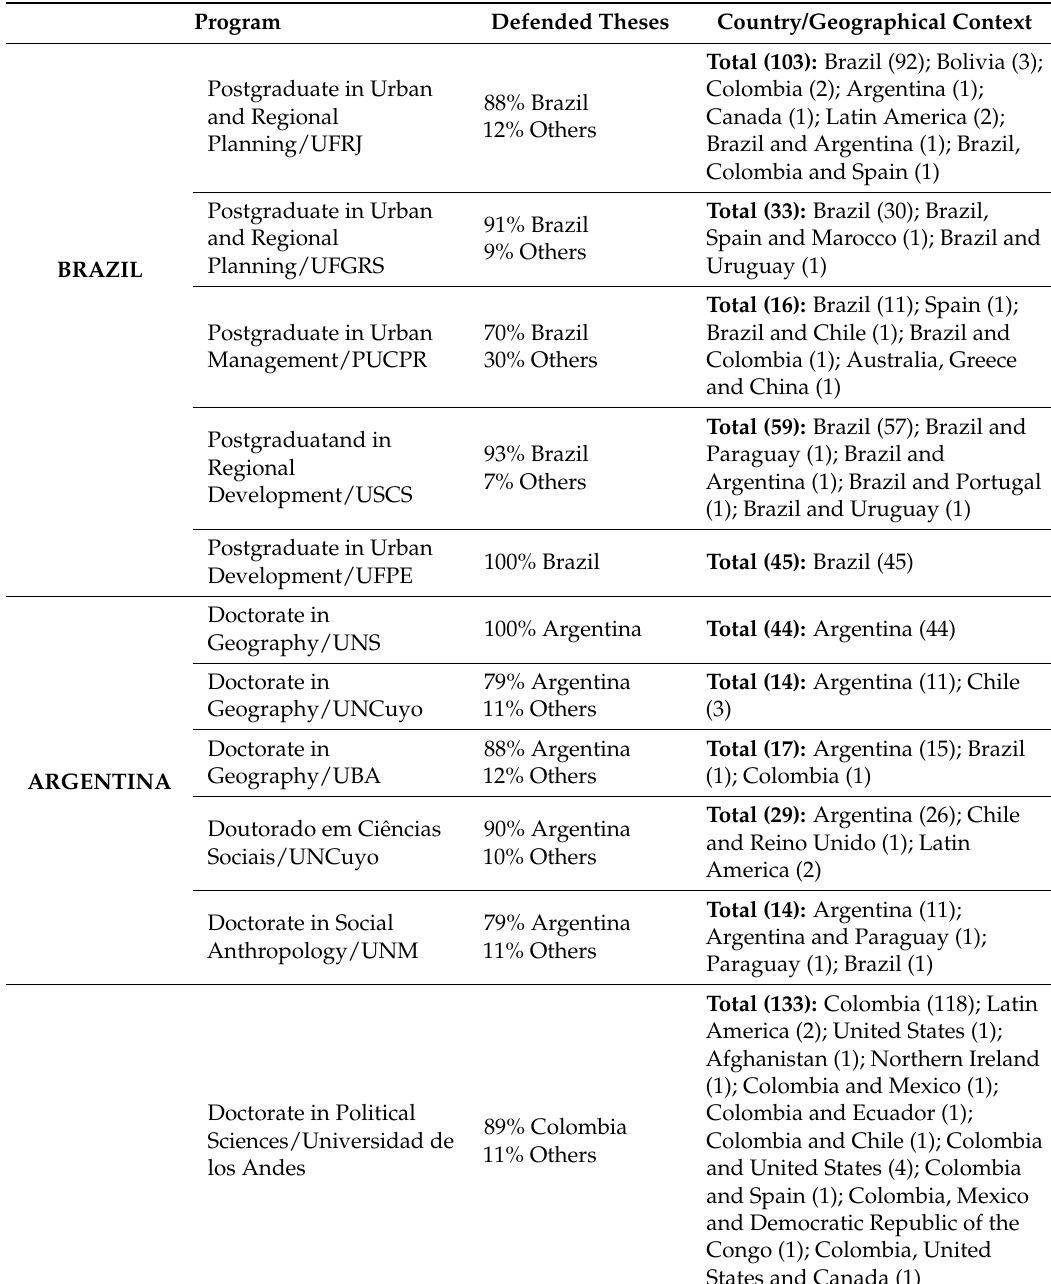
Table 5. Geographical frame (countries) adopted in dissertations of chosen post-graduation programs in selected